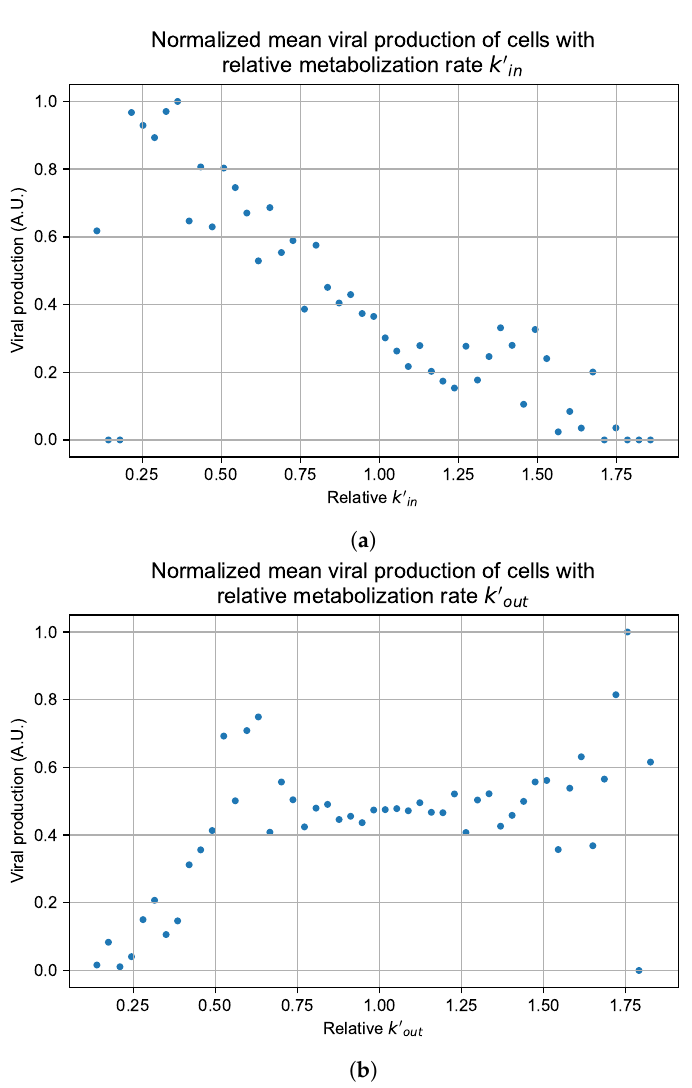
Figure 12. Mean viral production of cells versus their relative metabolic rates normalized by the maximum mean production with partial containment parameters. ( a ) Results for simulations varying only k in , uses the partial containment parameter set. ( b ) Results for simulations varying only k out , uses the widespread infection parameter